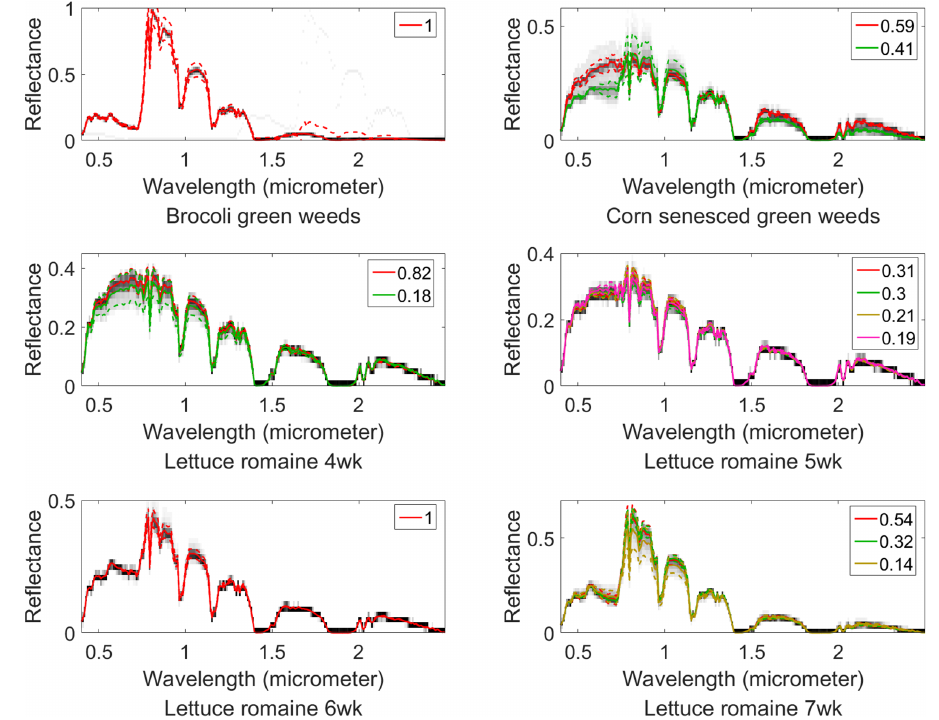
Figure 12. The wavelength reflectance space of the endmember signature estimated for the Salinas-A dataset, which has the same meaning as in Figure 5.